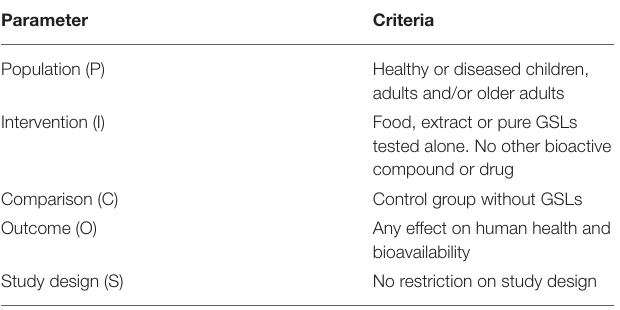
TABLE 2 | The number of registered trials on GSL-rich foods and extracts or pure compounds, according to their characteristics. Foods ( n =